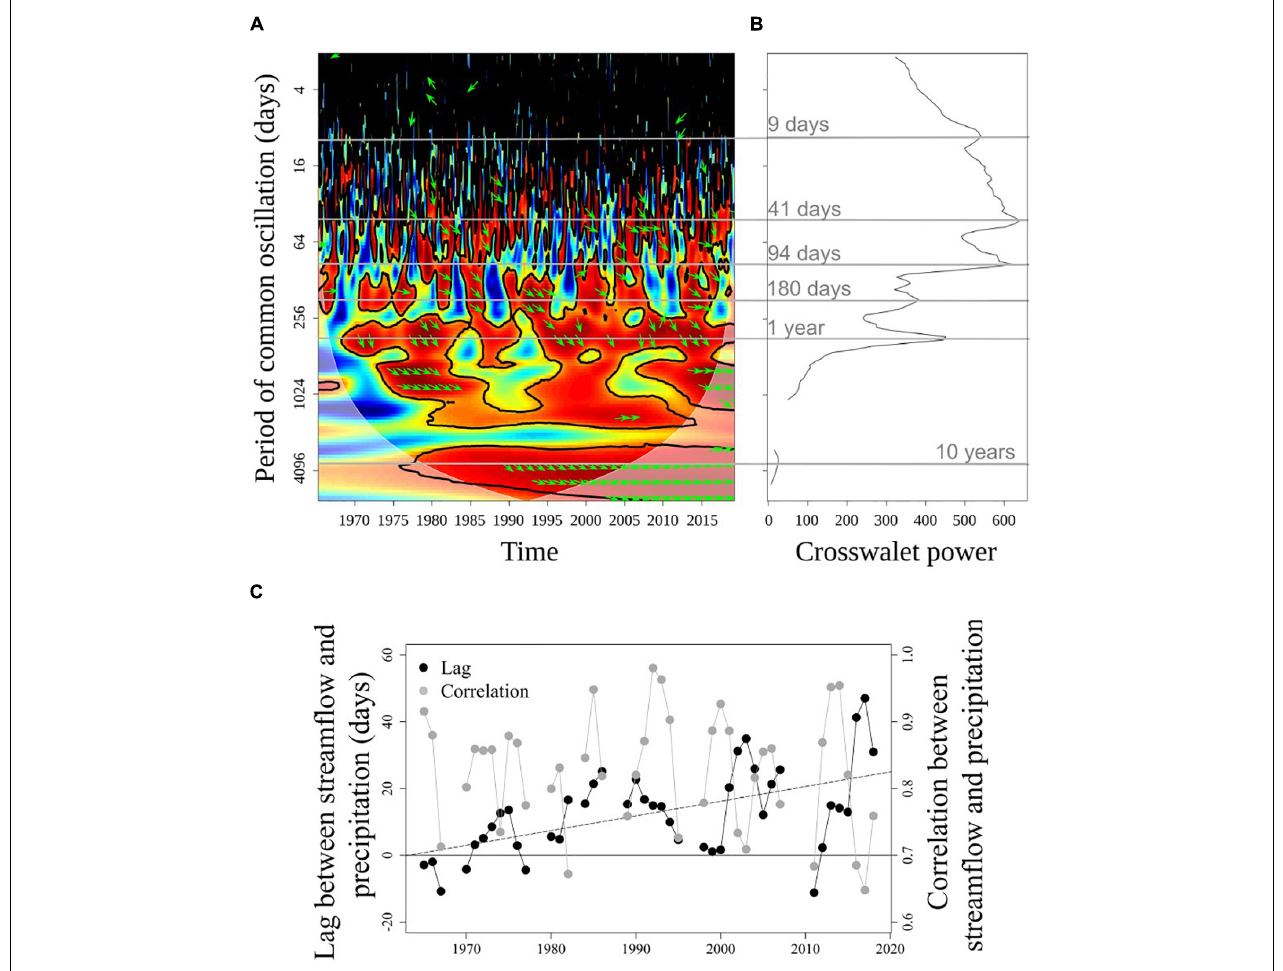
FIGURE 6 | Cross-wavelet transform and coherence analyses for the precipitation (in Puerto Montt) and streamflow time series (PD in Figure 1 ). (A) Cross-wavelet coherence plot, with significant regions delimited with a thick continuous line. Red colors denote high correlation. Shaded area is the cone of influence, where interpretations should be cautious. (B) Global cross-wavelet power showing the main periods of common oscillation. (C) Temporal lag (in days respect the precipitation series) and correlation between precipitation and streamflow analyzed at a period of 180 days. The dashed line is a linear trend for the lag, while the correlation did not show a significant trend. In panels b and c non-significant periods, lags, and correlations are not